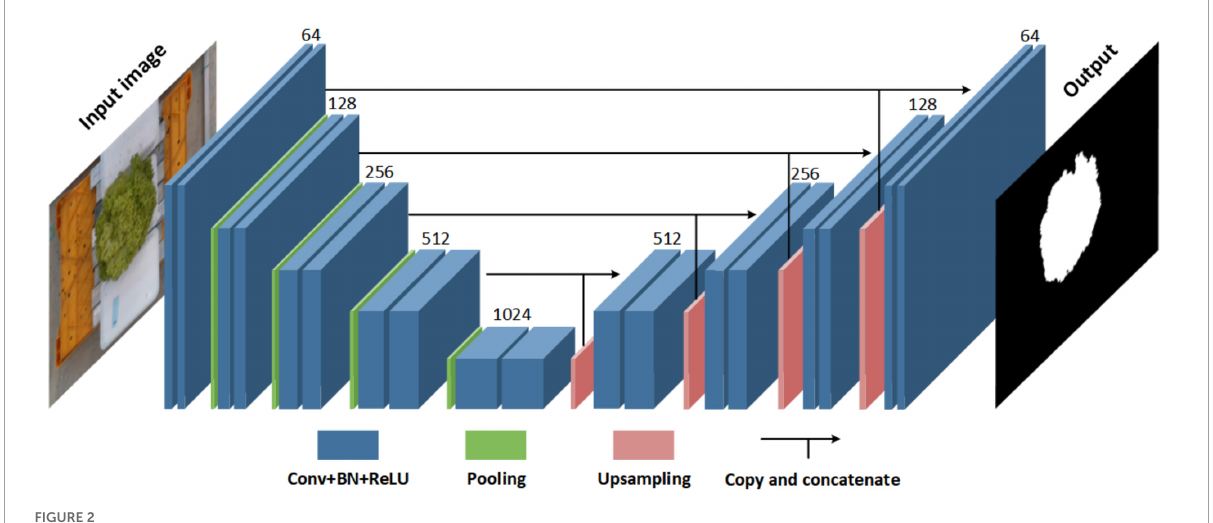
FIGURE2 The structure of the U-Net based leaf segmentation network.